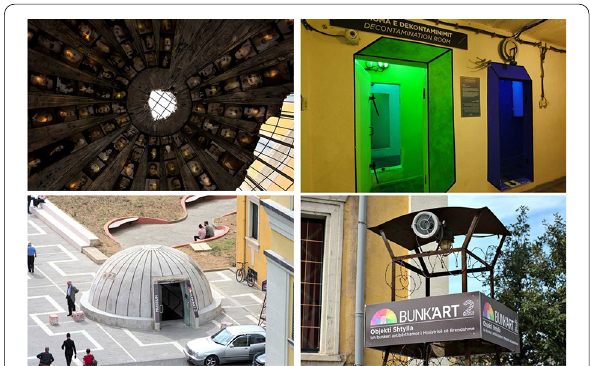
Fig. 10 Photos from the interior of the museum Bunkart 2,